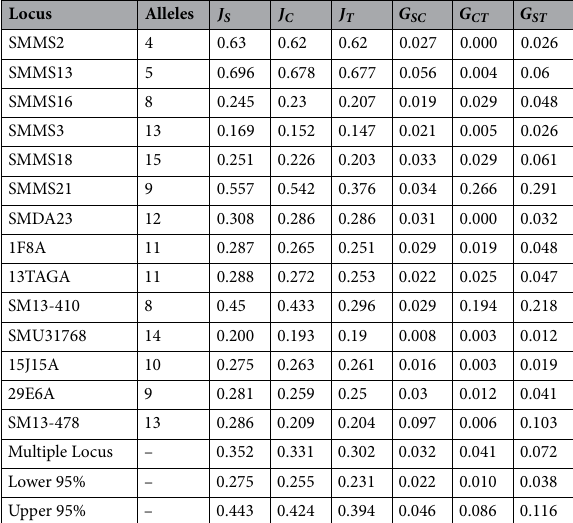
Table 1. Genetic loci and